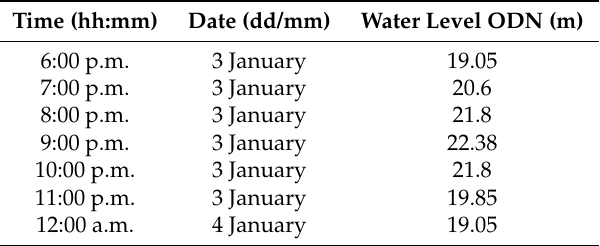
Table 2. The water level used for each hourly interval modelled in NEWRANS. Water level is provided with reference to Ordnance Datum Newlyn